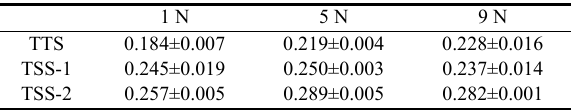
Table 1 Mean coefficient of friction of tailored Ti 3 AlC 2 ceramic against SUS304 balls along different texture directions